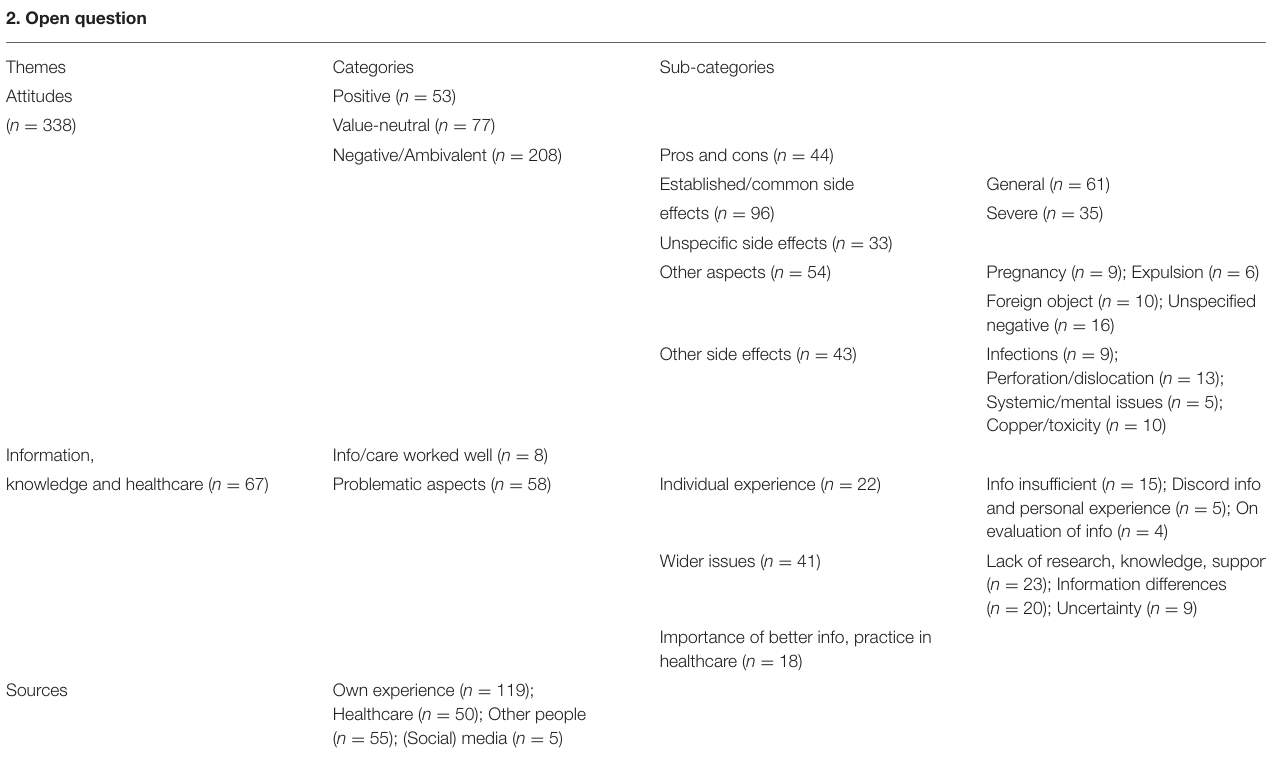
TABLE 7 | Open-survey responses regarding the copper IUD: themes and